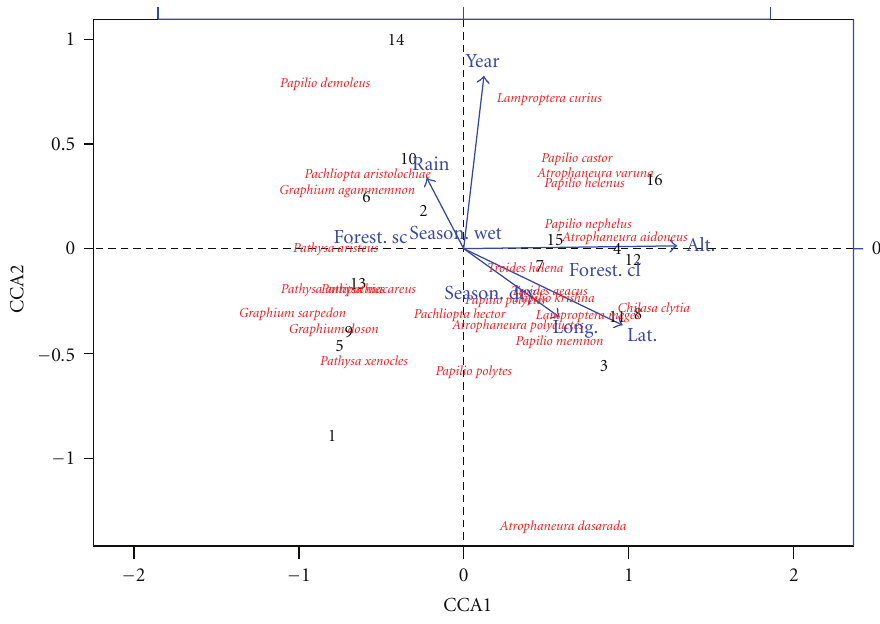
Figure 4: Ordination plots of CCA of papilionid species matrix on sampling locations of Garbhanga (a) and Rani (b) ranges during the wet and dry seasons of 2003-2004. Note : Lat for latitude, Long for longitude, Alt for altitude, Forest CL for closed forest, Forest SC for scattered/open